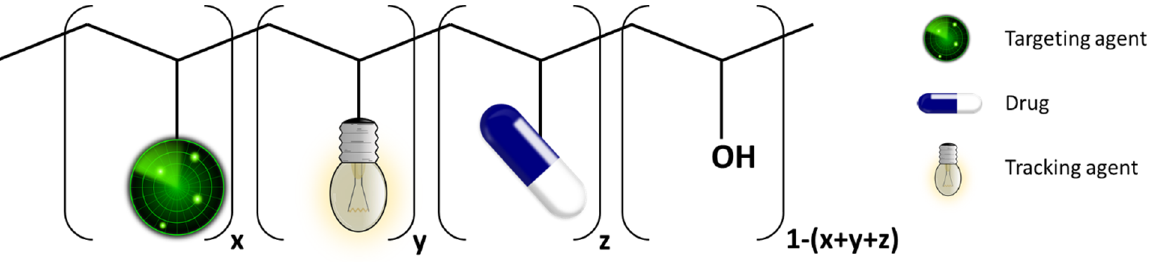
Figure 1. Sketch of the proposed multifunctional polymer conjugate structure. The terms x, y, and z indicate the molar fraction in the statistical polymer.